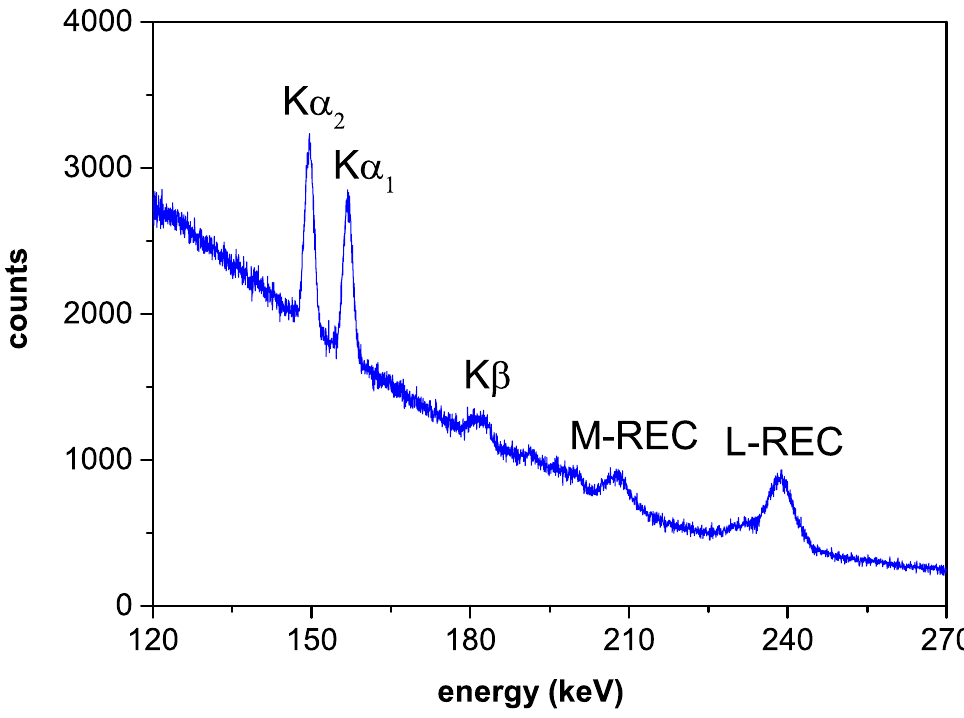
Figure 1. X-ray spectrum recorded for 218 MeV/u U 90 + → H 2 collisions with a Ge(i) detector at the observation angle of 35 ◦ with respect to the ion beam. The radiative electron capture (REC) transitions into L, M and higher shells are clearly visible together with the characteristic transitions into the